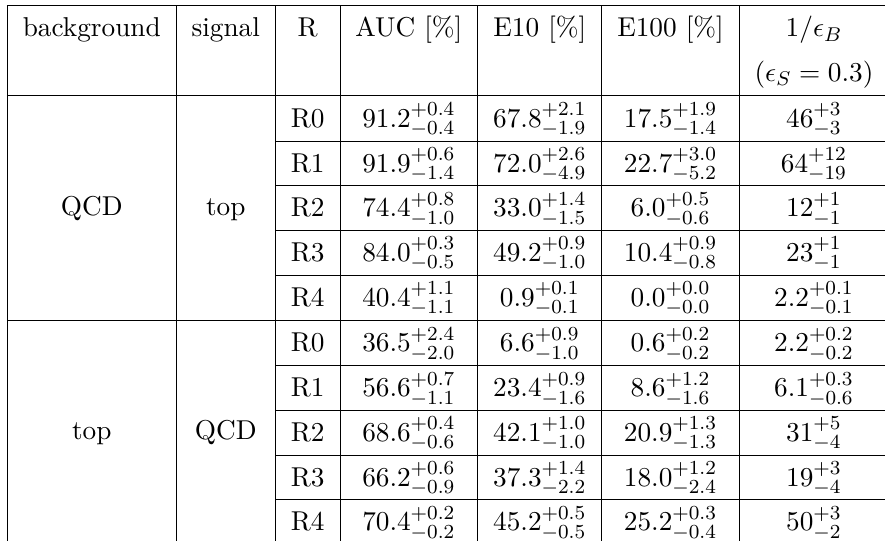
Table 1 . Performance measures for AE-based taggers for different remappings of the jet images trained using MSE. Each value is an average of values for 4 autoencoders trained using the same hyperparameters but different initialization. The mentioned uncertainties denote the envelope of each value.